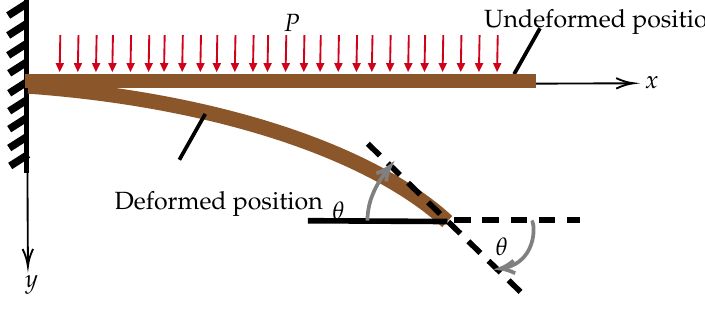
Figure 1. Undeformed and deformed positions of a cantilever beam subjected to a uniformly dis- tributed